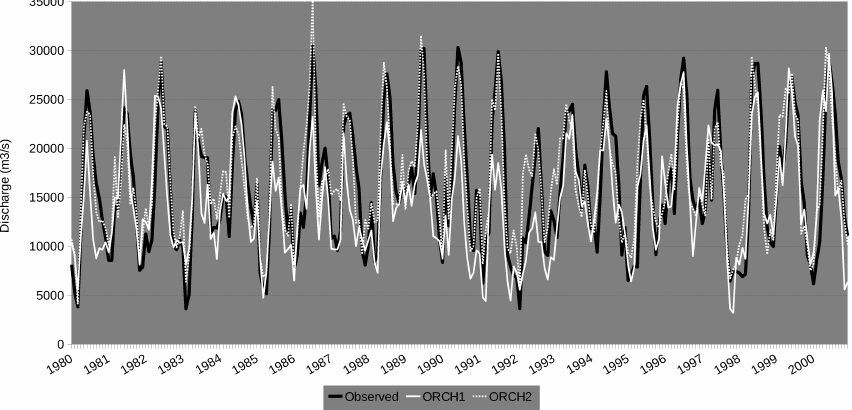
Fig. 12. Interannual variation of monthly discharge (m 3 s − 1 ) at Serrinha for simulations ORCH1 and ORCH2 compared to observations, over the time period 1980–2000.